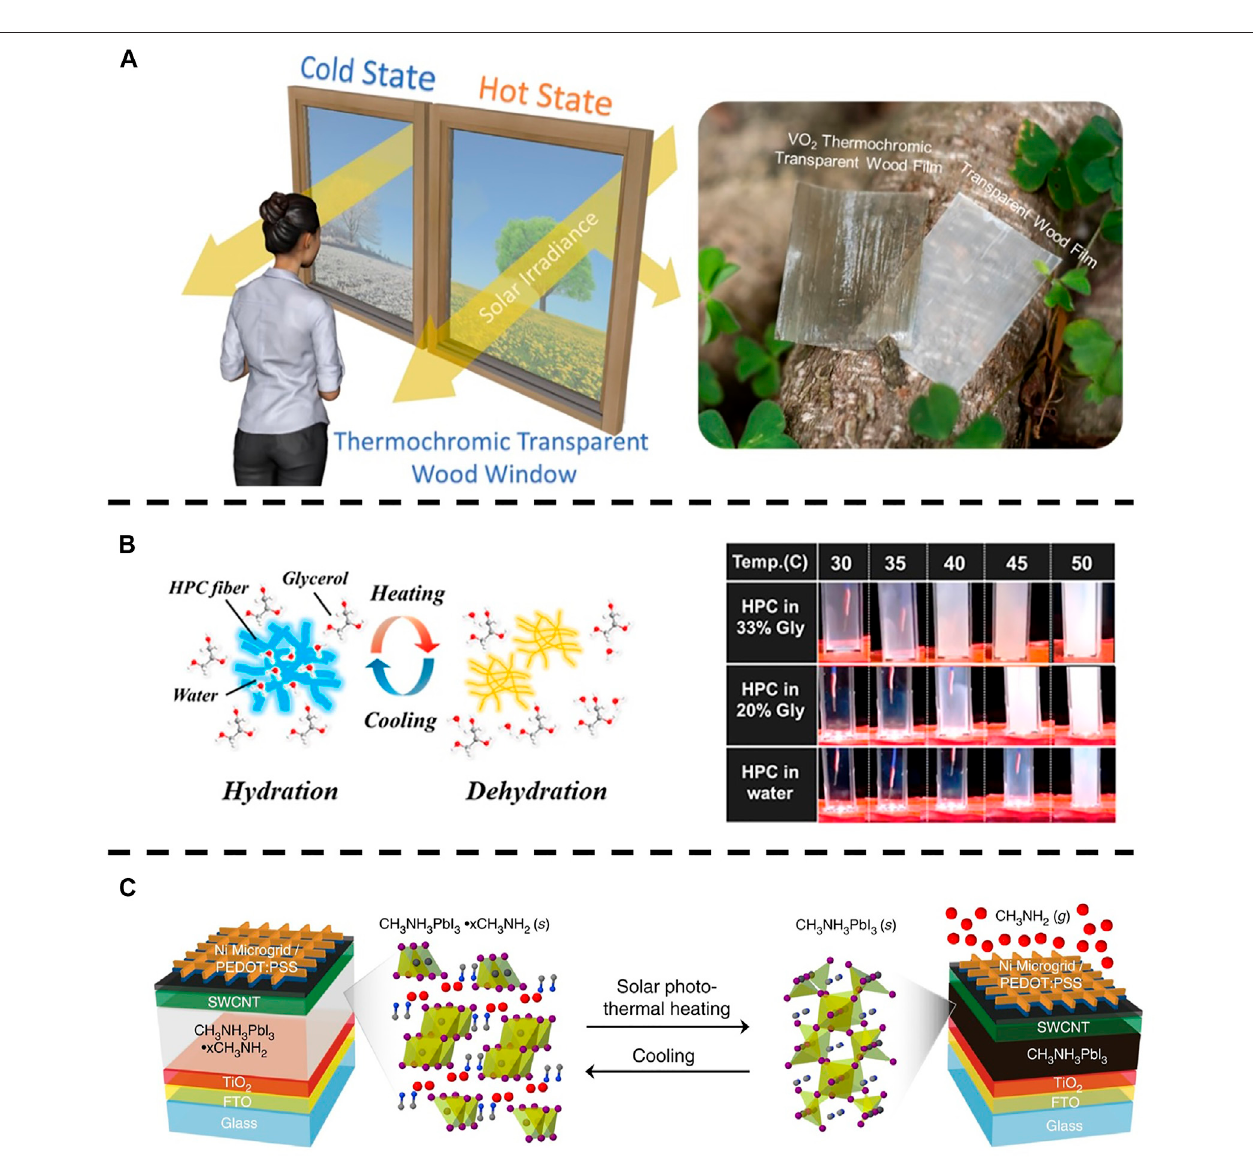
FIGURE 1 | (A) Illustration of thermochromic wood fi lm for smart windows. Adapted with permission from (Liu et al., 2021b), Copyright 2021 American Chemical Society. (B) Schematic of the interaction between hydroxypropyl cellulose, water, and glycerol. Adapted with permission from (Nakamura et al., 2019), Copyright 2019 American Chemical Society. (C) Schematic of switching process of PV smart windows. Adapted with permission from (Wheeler et al., 2017), Copyright 2017 Springer Nature.